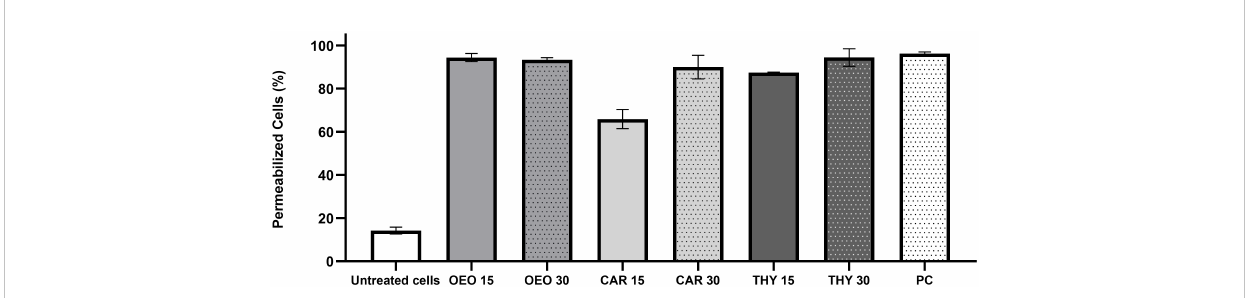
FIGURE 4 Percentage of X. citri cells with damaged membranes. OEO, oregano essential oil; CAR, carvacrol; THY, thymol; PC, positive control for permeability (cells submitted to thermal stress). Numbers 15 and 30 indicate the duration of the exposure period. Whiskers represent the standard deviation of the mean; 200 cells were analyzed per treatment